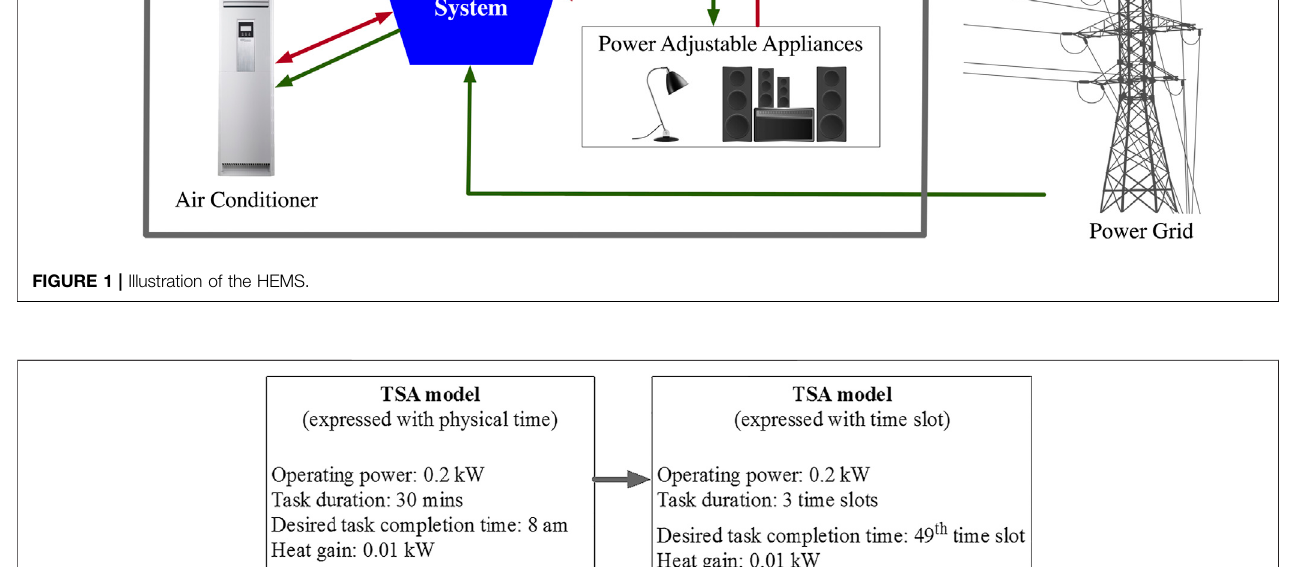
Frontiers in Energy Research |